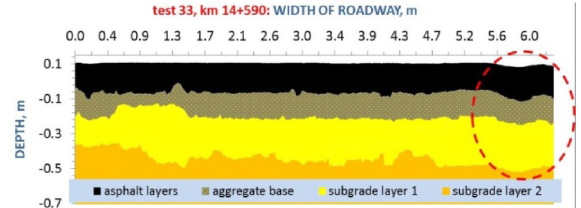
Fig. 1. An example of technical condition of the lower pavement layers after 3 years of pavement serviceability since the rehabilitation by using only a new asphalt layers